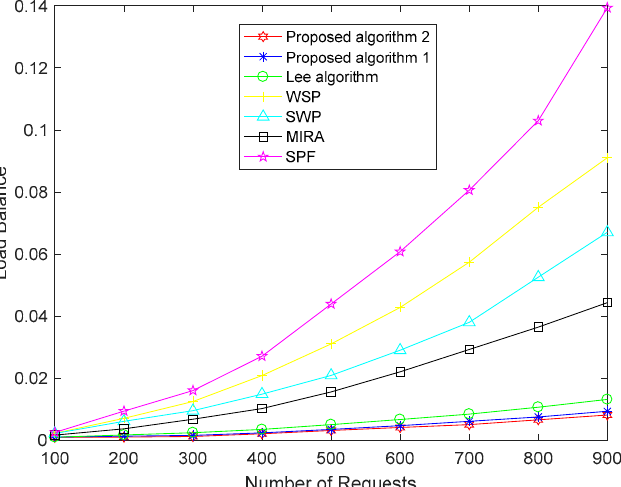
Figure 5. Load balance of the seven algorithms.